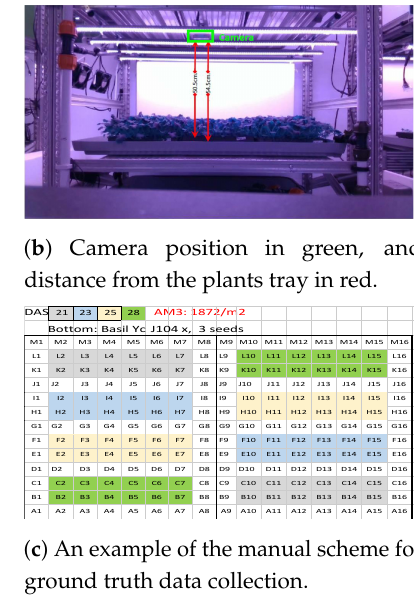
Figure 2. Experiments setting within the Agricola Moderna laboratory. ( c ) Each cell indicates a basil plant, for a high density tray collecting plugs of the Yc